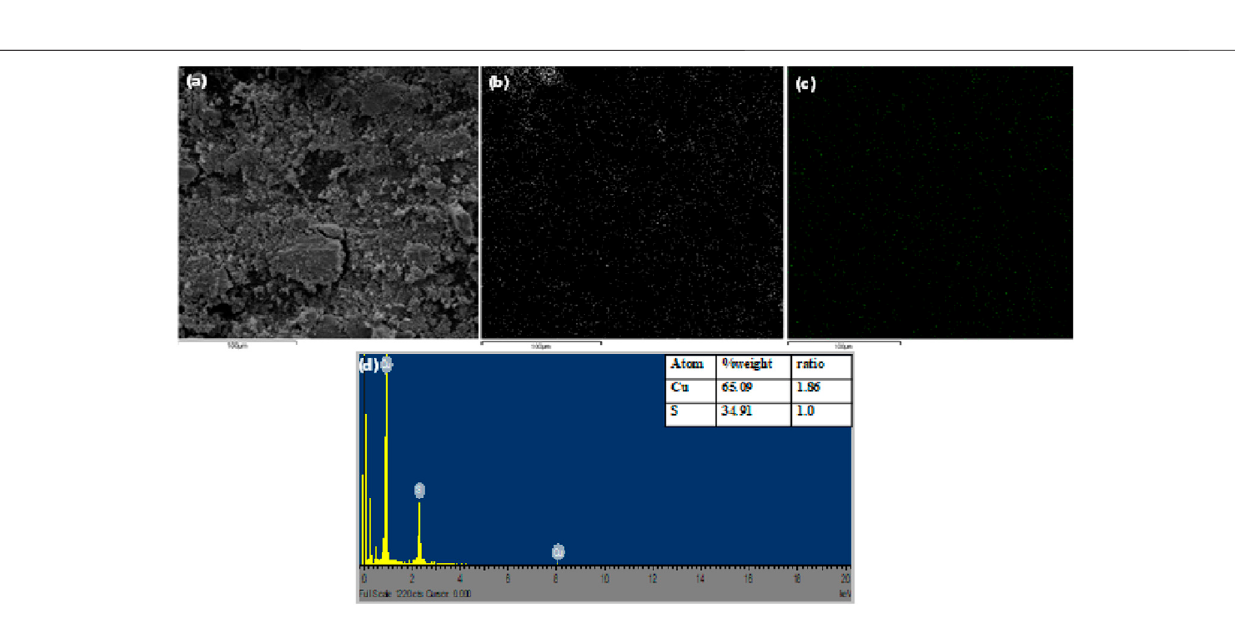
Frontiers in Materials |